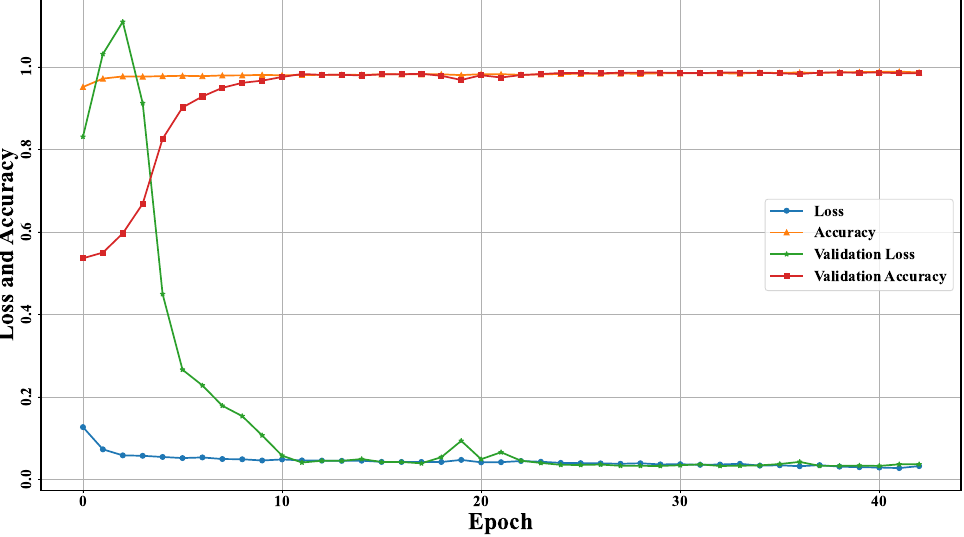
Figure 10. Accuracy–loss curves for WaterUNet with a batch size of 128.